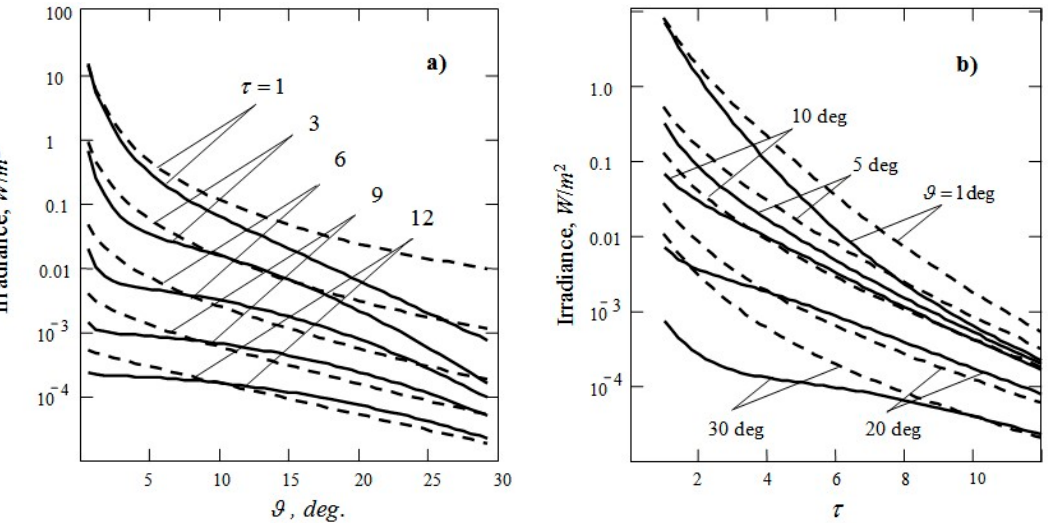
Figure 2. Irradiance from unidirectional point source (UPS) depending on the polar angle ( a ) and optical distance ( b ), calculated according to new formulas (solid curves) and to Equation (64) (dotted curves); the numbers in ( a , b ) indicate the values of τ and ϑ , respectively; source power 1 W, c = 0.4 m − 1 .